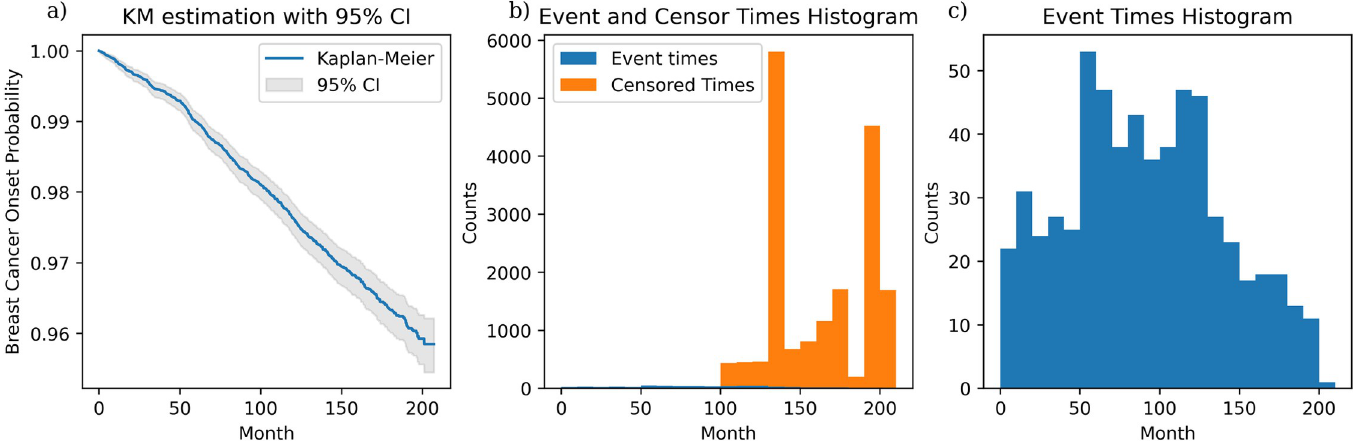
Fig 3. Kaplan-Meier estimation of the ATP-BCa dataset and the uncensored/censored time histograms. (a) Kaplan-Meier estimation with 95% confidence interval. Note that the y-axis starts from 0.95; (b) Uncensored (blue) and censored time (yellow) histogram of the participants in the ATP-BCa dataset; (c) Rescaling, and showing only the uncensored time histogram of the ATP-BCa